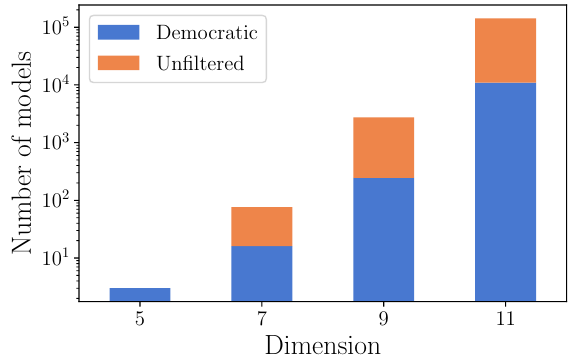
Figure 12. The bar chart shows the number of distinct Lagrangians derived from operators of different mass dimension. The orange bars show the number of distinct unfiltered models. The blue bars show the number after democratic filtering. The number of filtered completions grows with mass